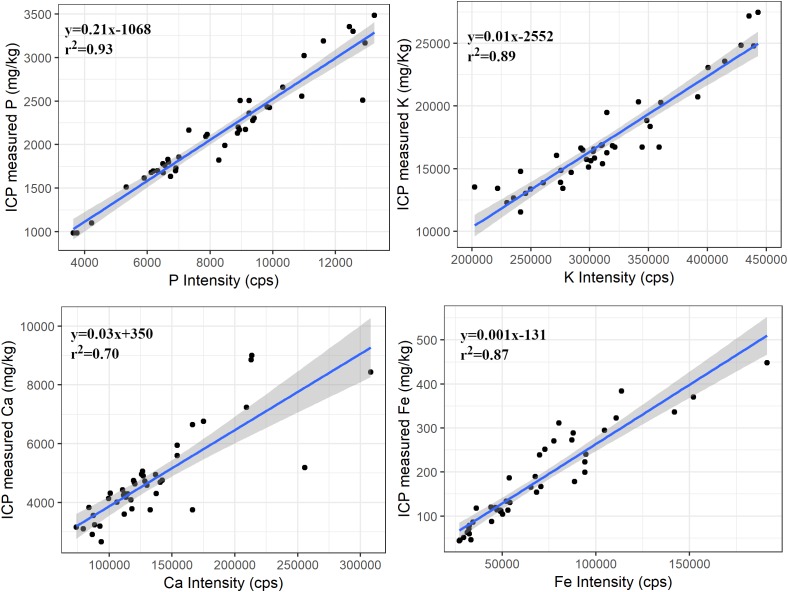
Regression plots between ICP measured concentrations and PXRF intensity of P, K, Ca, and Fe for the ≤0.5 mm samples. The shaded portion represents the standard error of the regression line. The relationship was significant (p < 0.001) for all elements.